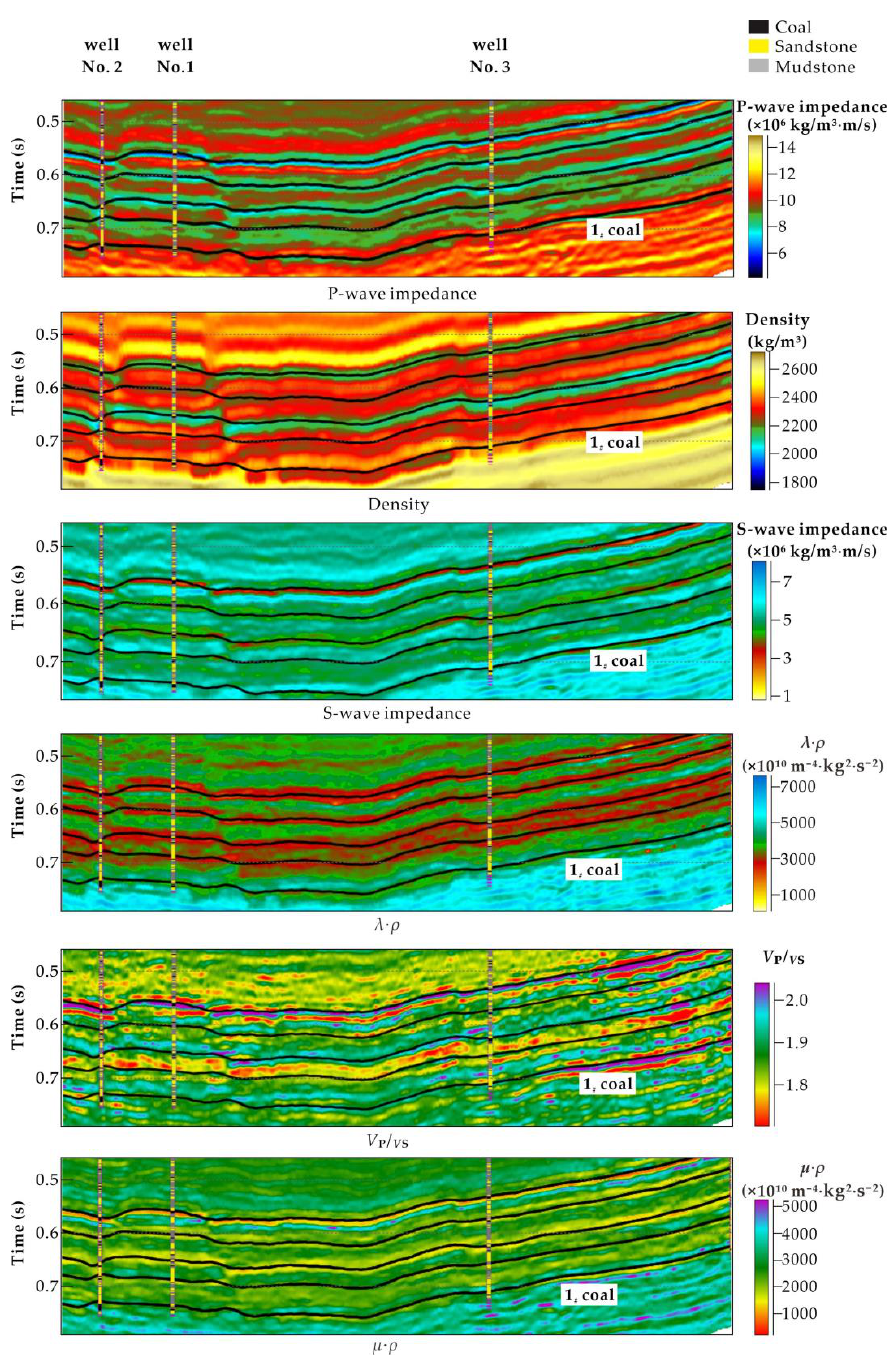
Figure 12. Parameter profiles of P-wave impedance, P-wave velocity ratio, density, λ · ρ , µ · ρ , and Poisson ’ s ratio.